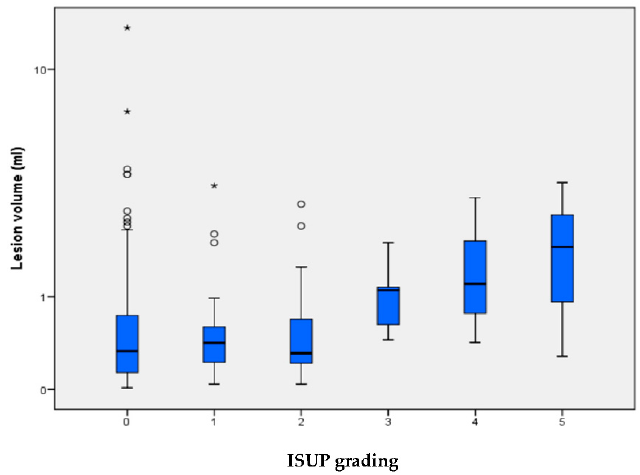
Figure 2. Lesion volume is indicated for each of the ISUP grading groups, for which ISUP 0 signifies no carcinoma/benign histology. The median (±IQR) lesion volume with whiskers within 1.5 times the IQR. Circles are lesions between 1.5 and 3 times, asterisks are lesions with >3 times IQR deviation from the third quartile. One benign outlier with a lesion volume with 42 mL is not depicted in the graphical representation for clearer visualization. The lesion volume correlates with ISUP grading ( p = 0.0076, Kruskal-Wallis-Test).